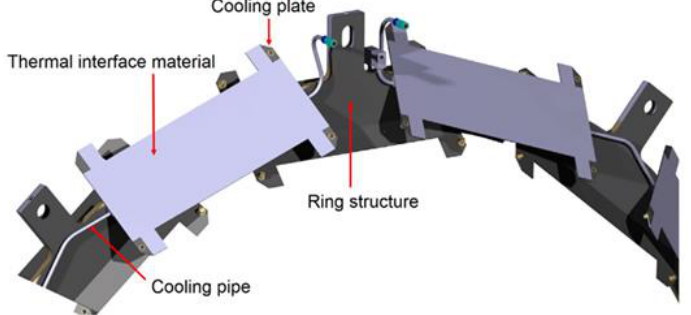
Figure 1. CAD drawing of the TOB showing the complex routing of thin-walled pipes at the CMS